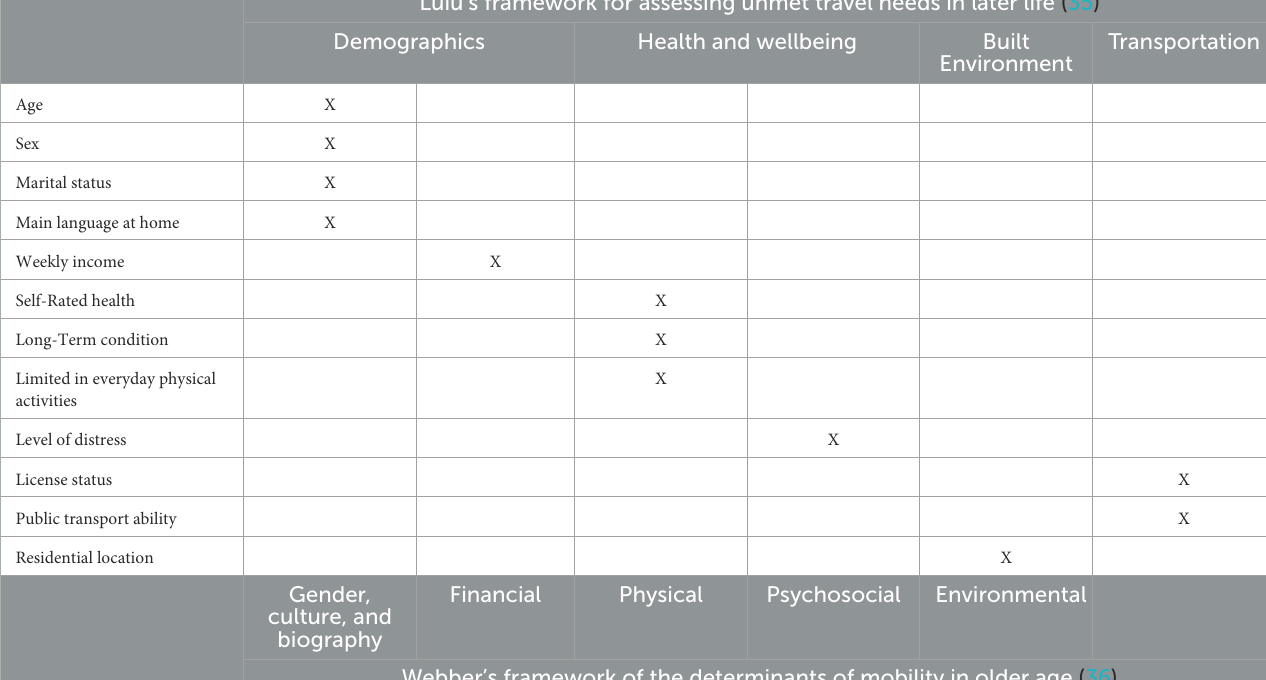
TABLE 1 Predictor